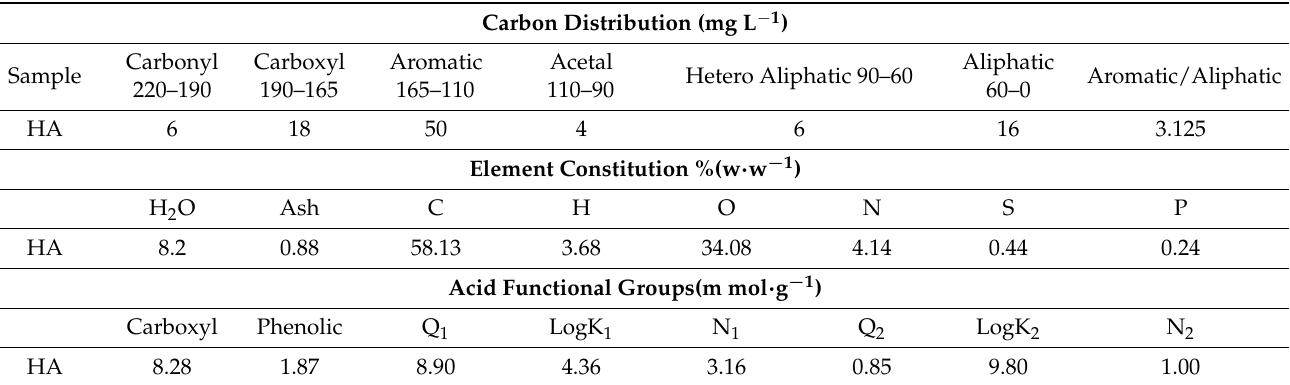
Table 1. The elemental composition, functional groups and NMR analysis of